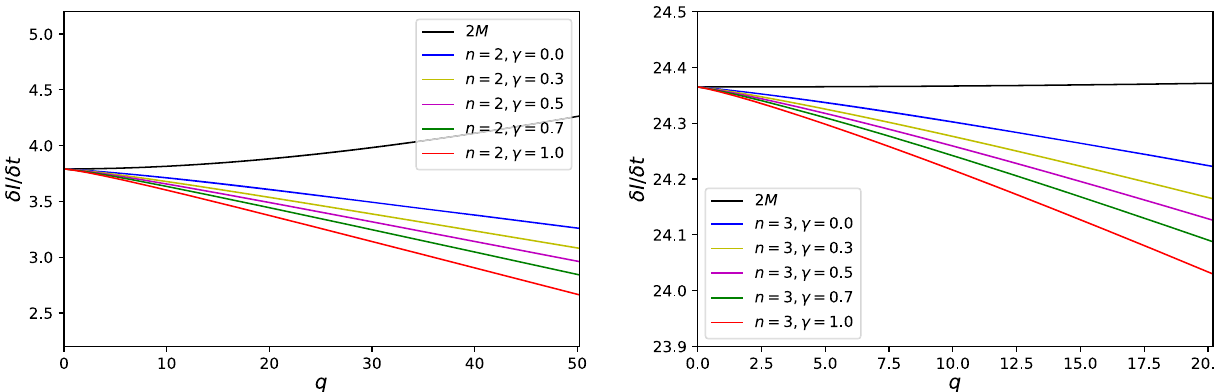
Fig. 4 δ I δ versus q for the purely electric black holes with single horizon. The black line on each plot is the 2 M line. The parameters are fixed as t β = 0 . 2 , r + = 3 ,(cid:3) = −